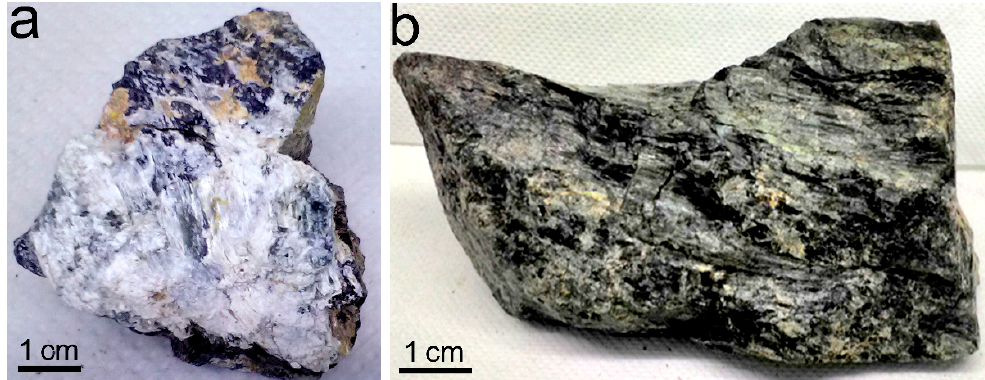
Figure 3. ( a ) White and silky tremolite on the surface of a serpentinite sample at the mesoscopic scale; and ( b ) the characteristic blazing surface of serpentinite, looking like a snake’s skin.